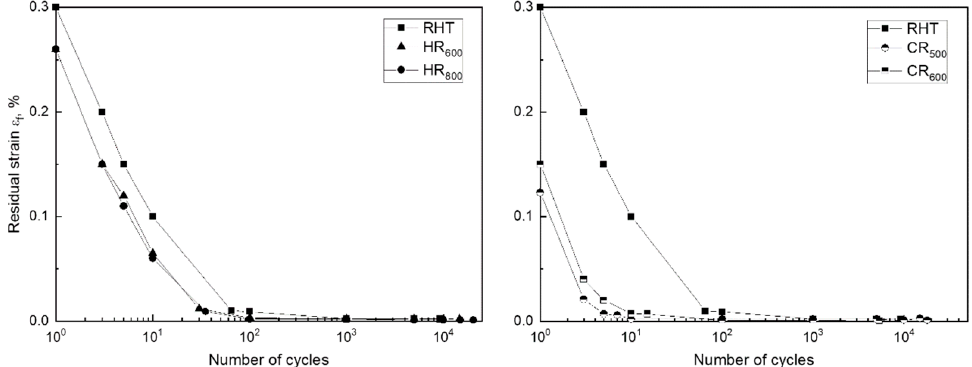
Figure 5. Evolution of the residual strain in the cycle of the Fe-30Mn-5Si alloy after various treatment regimes. The error limits do not exceed the size of